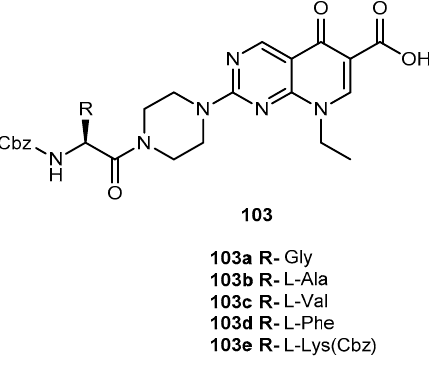
Figure 43. Structures amino acid pipemidic conjugates ( 103a – e ).